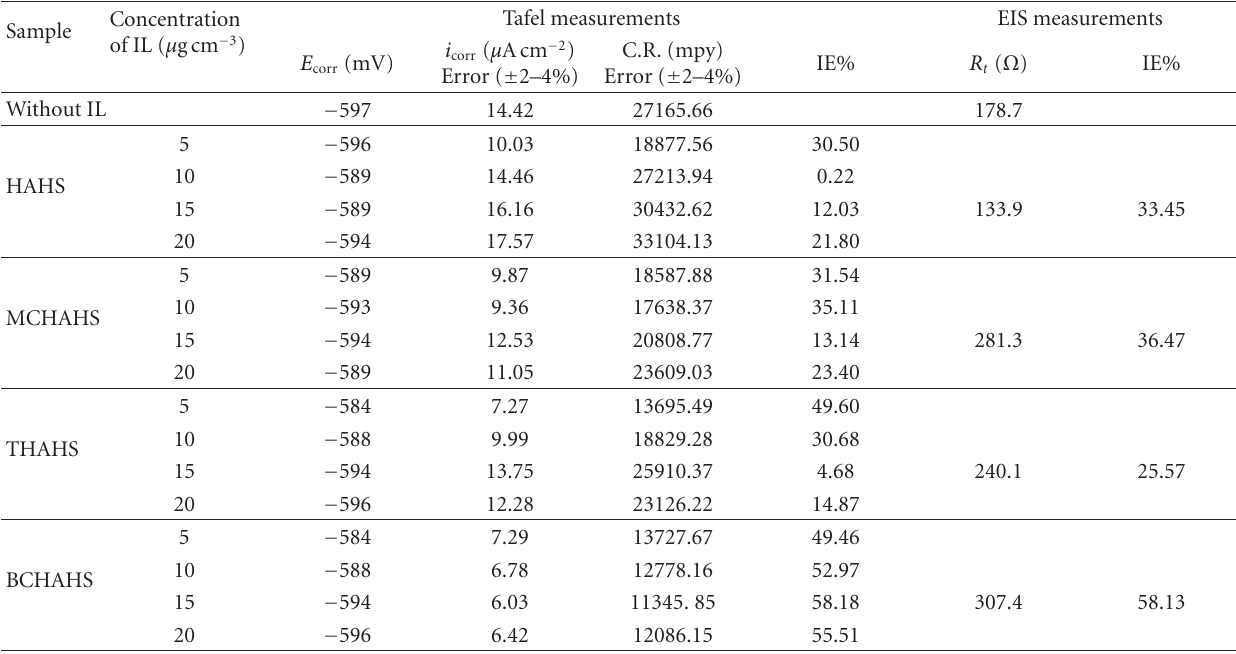
Table 1: Corrosion data for Pb1.6 wt% Sb alloy in 4.0 mol · L − 1 H 2 SO 4 in presence and absence of ionic liquids obtained from Tafel polarization and electrochemical impedance spectroscopy methods.